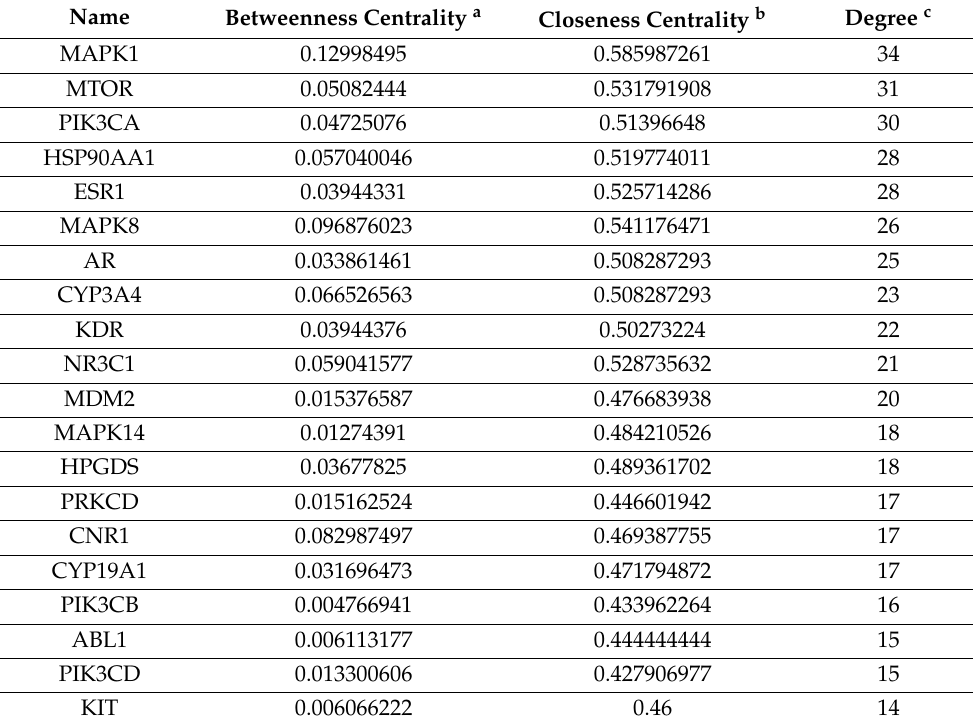
Figure 6. STRING PPI network for the top 20 targets identified by network analyzer for ST-1 as a potent gastric H+/K+-ATPase inhibitor. Table 2. Network topological analysis for the predicted targets for ST-1